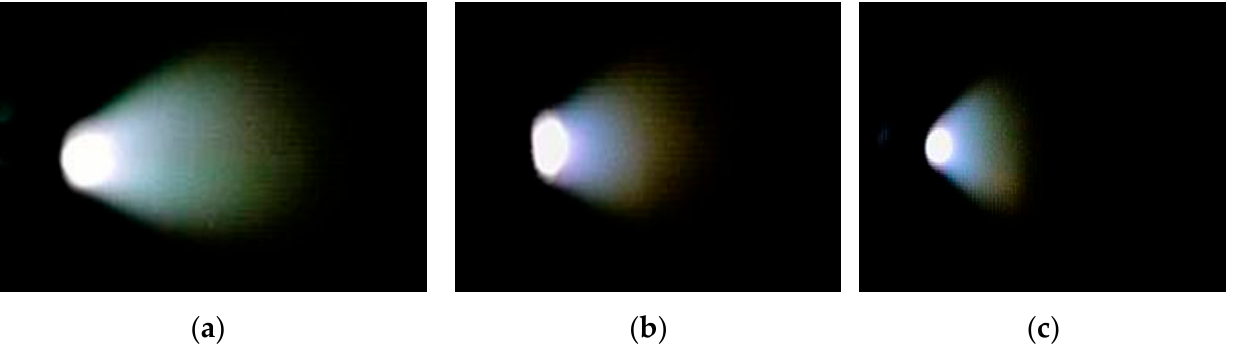
Figure 10. Time integrated pinhole images of the plasma plume during thin film deposition: ( a ) new target surface, ( b ) after 3000 laser shots, ( c ) after 6000 laser shots.